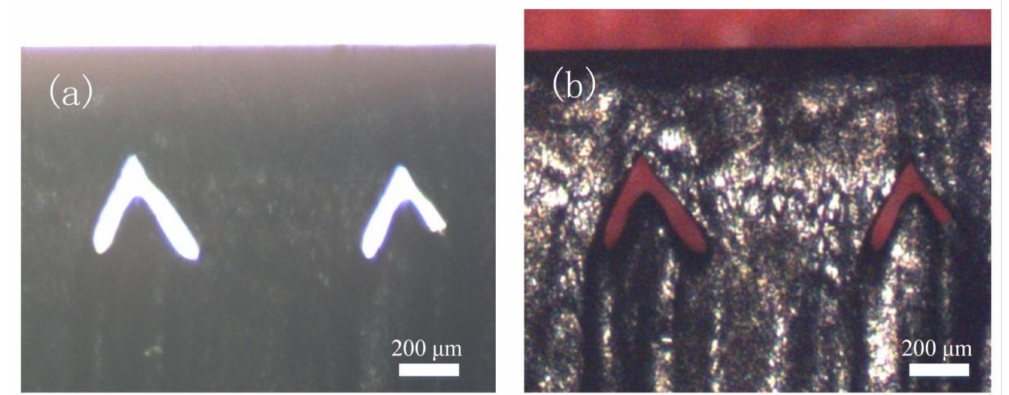
Figure 8. Cross-section optical microscope images of SCD microchannels with various backlights from ( a ) white light; ( b ) red